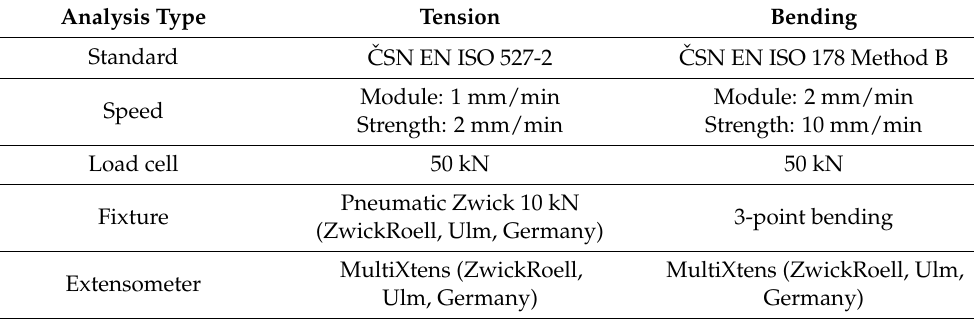
Table 7. Tensile and flexural analysis conditions.